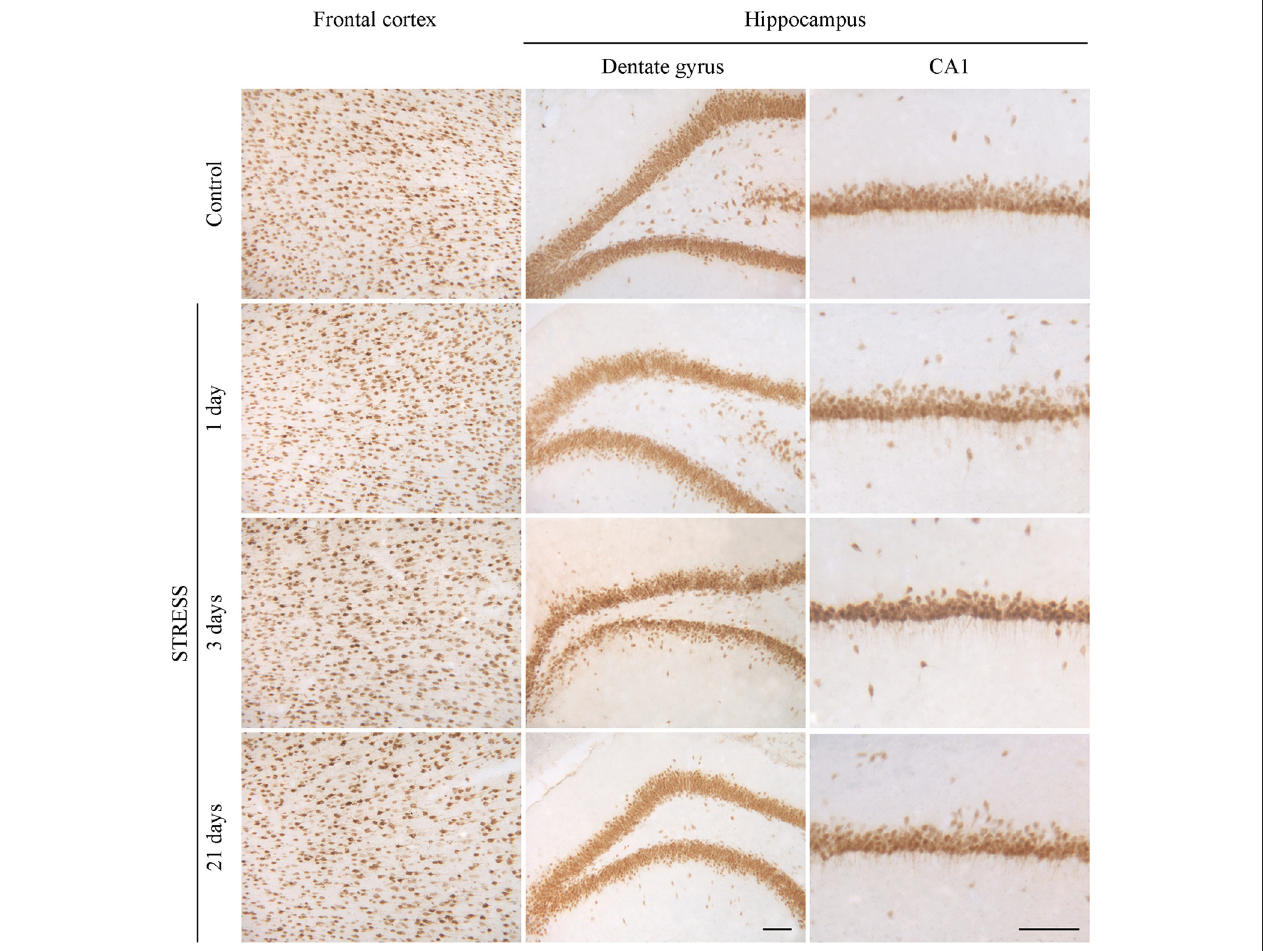
FIGURE 10 | Effect of restraint stress on NeuN immunoreactivity in the frontal cortex and hippocampus of rats. The NeuN immunostaining (brown color) revealed neuronal cell bodies and nuclei on brain sections of control and stressed rats. Scale bar: 100 µ m.